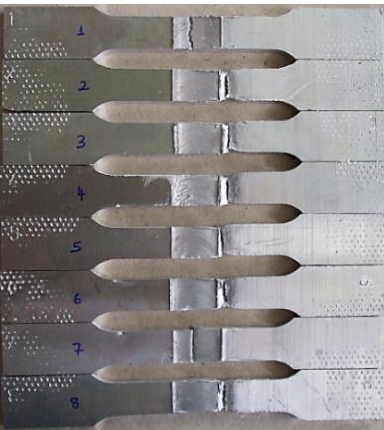
Figure 8. The fracture location of weld samples after tensile tests.